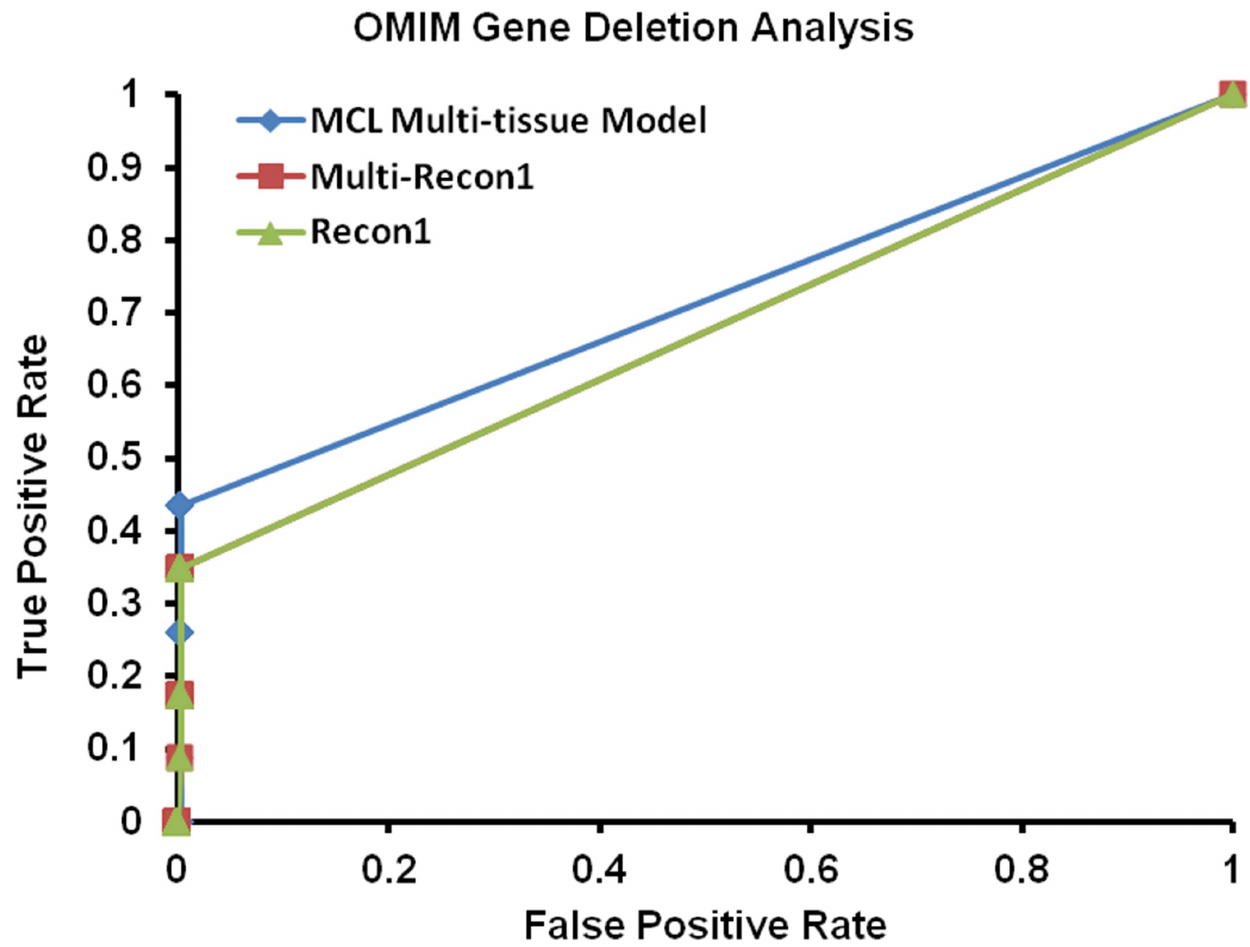
Figure 3. ROC plot for validation using OMIM data. ROC plot comparing different models using gene-deletion study. This figure demonstrates the true positive and false positive rates at various threshold values.